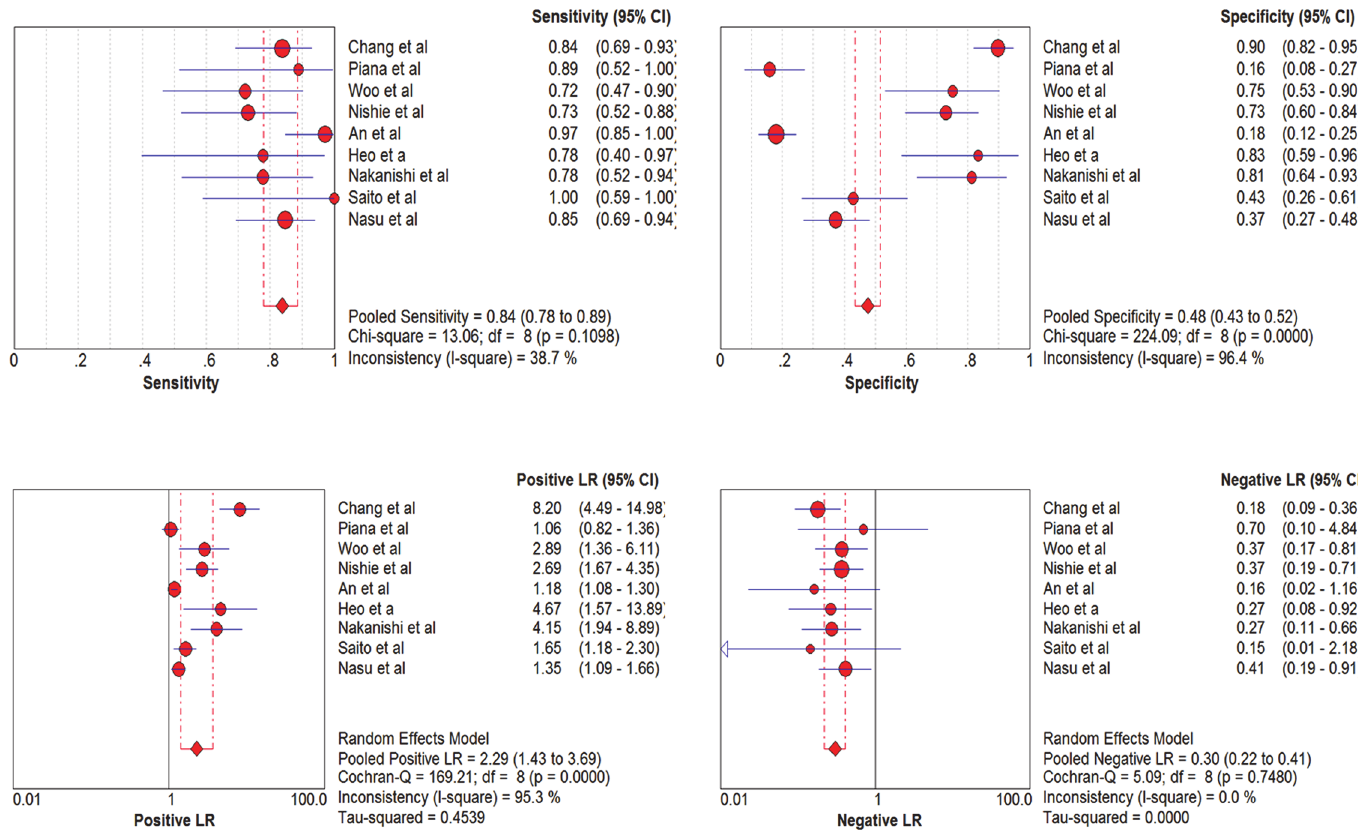
Fig 4. Forest plots of the estimates for DWI in predicting p-HCC. The Q statistics and I 2 indexes of specificity suggested the presence of notable heterogeneity, and the diagnostic performance was summarized by using a random-effects coefficient binary regression